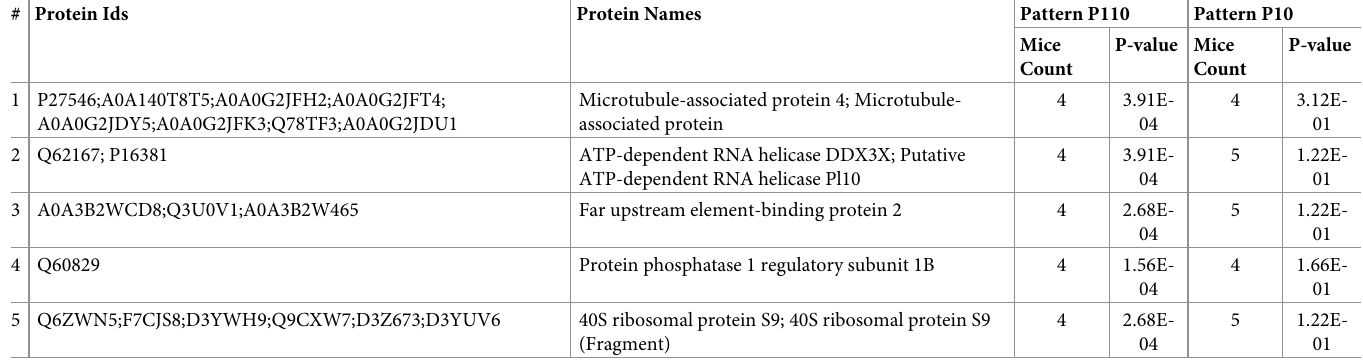
Table 2. Most abundant proteins with the pattern